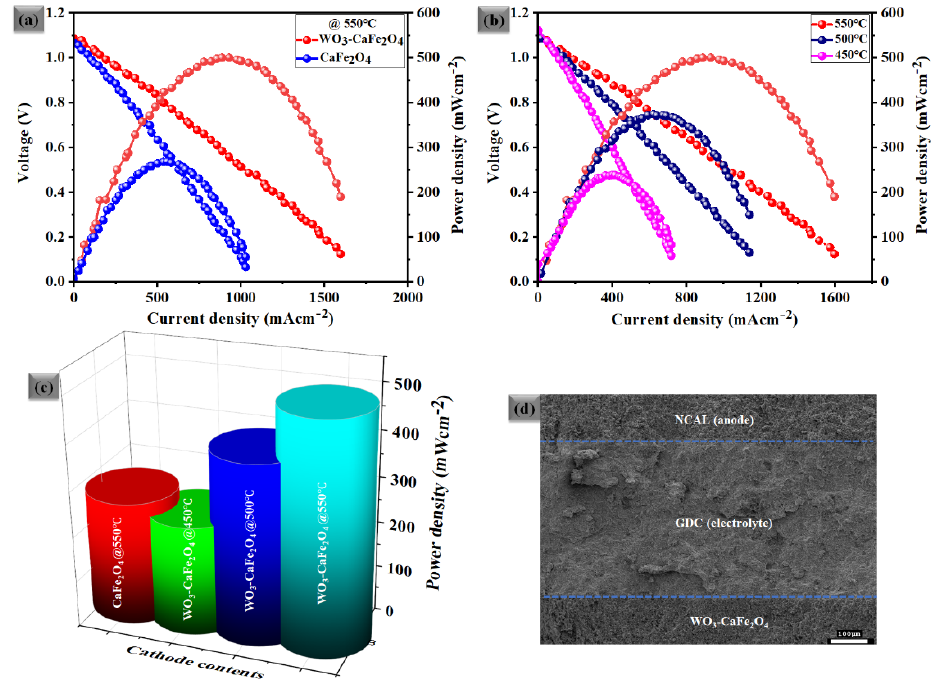
Figure 5. Characterization of Electrochemical performances: ( a ) I (cid:3398) V & I (cid:3398) P Characteristics curves of utilizing our prepared WO 3 (cid:3398) CaFe 2 O 4 in comparison of pure CaFe 2 O 4 as a cathode in fuel cell oper